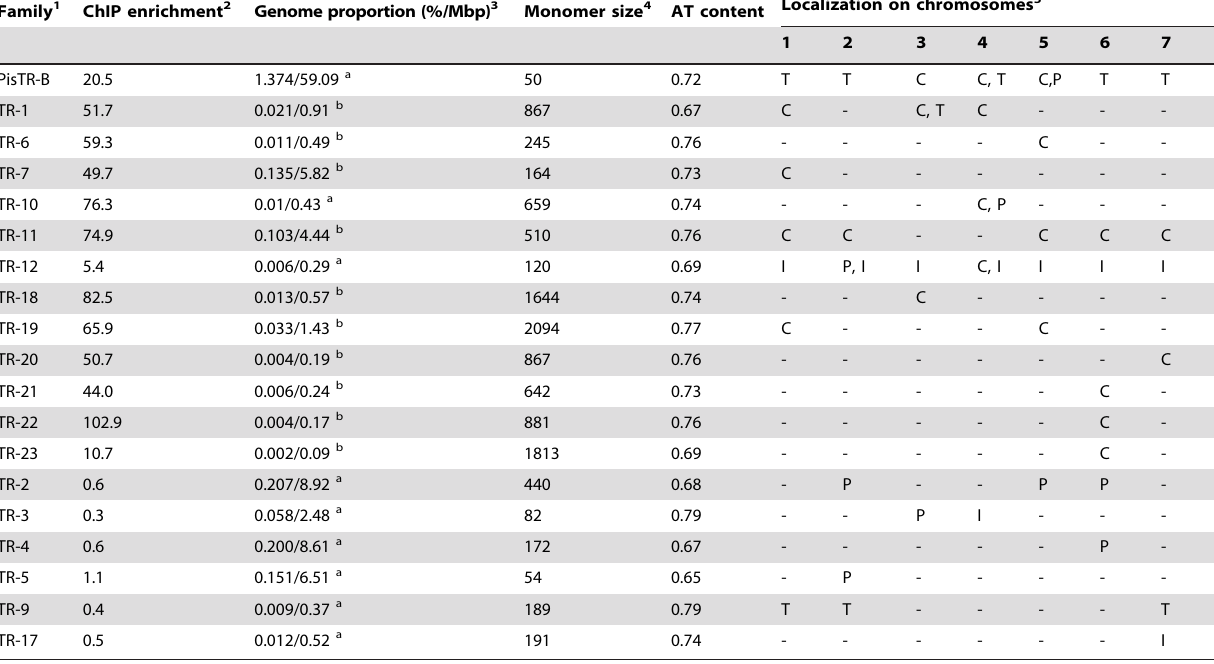
Family 1 ChIP enrichment 2 Genome proportion (%/Mbp)